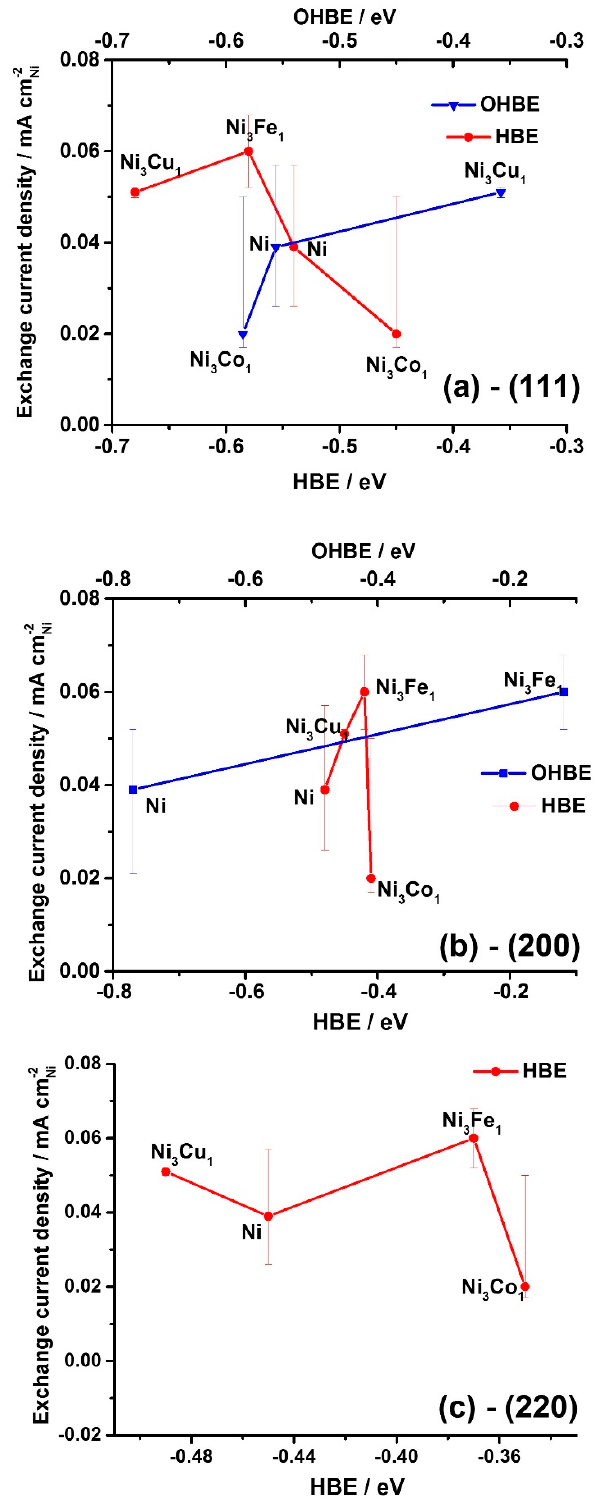
Figure 4. Correlation between the experimentally determined exchange current density values of the catalysts with the theoretically predicated HBE and OHBE values: ( a ) (111) facet, ( b ) (200) facet, and ( c ) (220) facet.